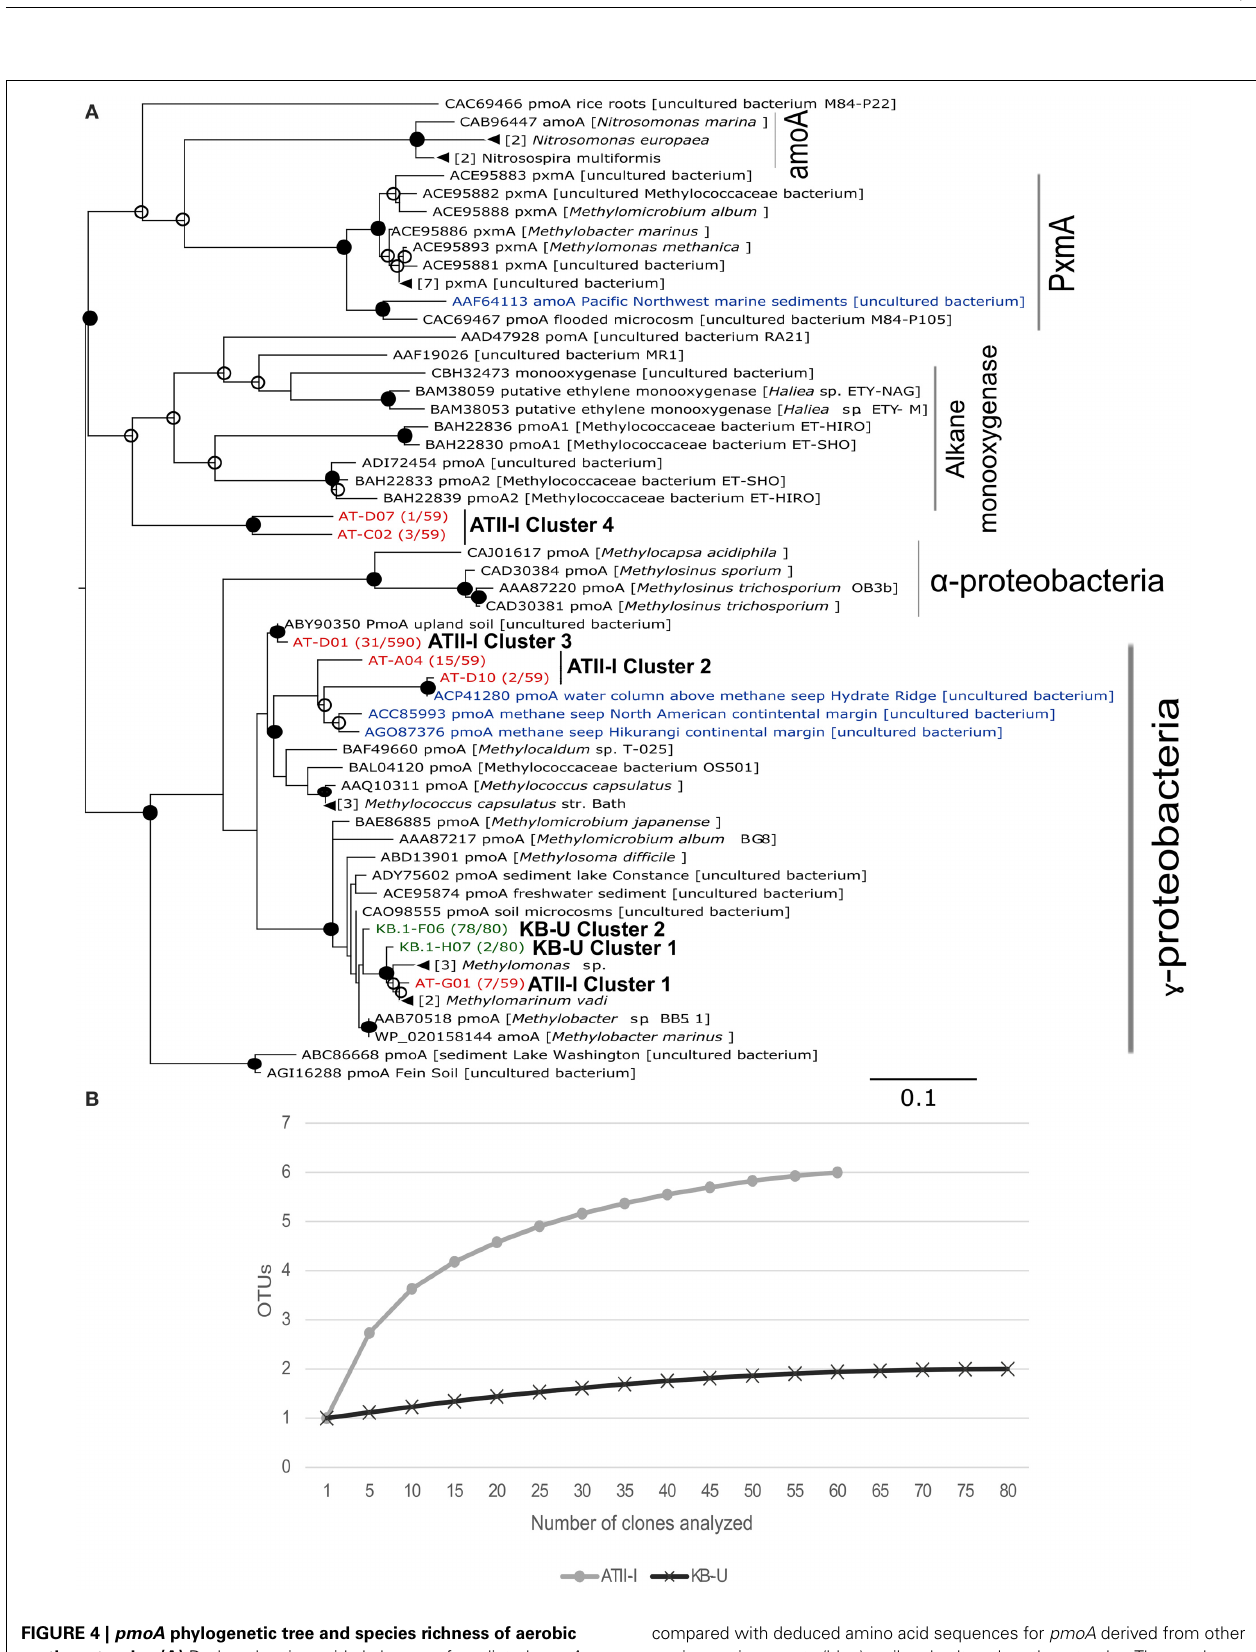
compared with deduced amino acid sequences for pmoA derived from other marine environments (blue), soil and cultured methanotrophs. The number between parentheses, following the sequence name, represents the